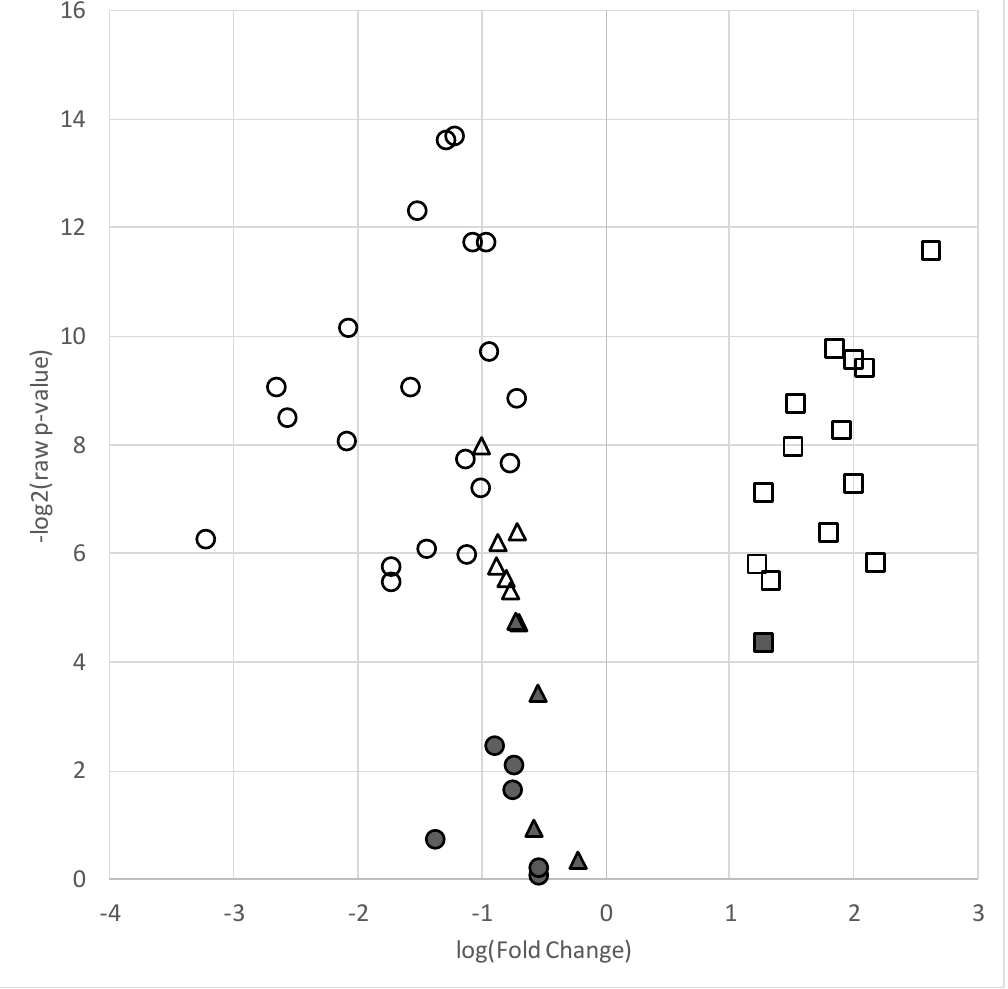
Figure 1. Volcano plot of lipid species in the AAP-treated group relative to the mood stabilizer group. Plot depicts log of –log2 p -value (y-axis) versus log base 2 of fold change (x-axis) of each individual lipid included in the analyses. Symbols higher on the y-axis indicate a more significant p -value and the greater distance from the center (“0”) indicates a decrease (negative log fold change) or increase (positive fold change) in the lipid level of the AAP group relative to the mood stabilizer group. ● = total fatty acids, ▲ = phosphatidylcholines, ■ = ceramides. Filled shapes are non-significant and empty (non-filled) shapes are significant based on a false discovery ( q -value < 0.05).